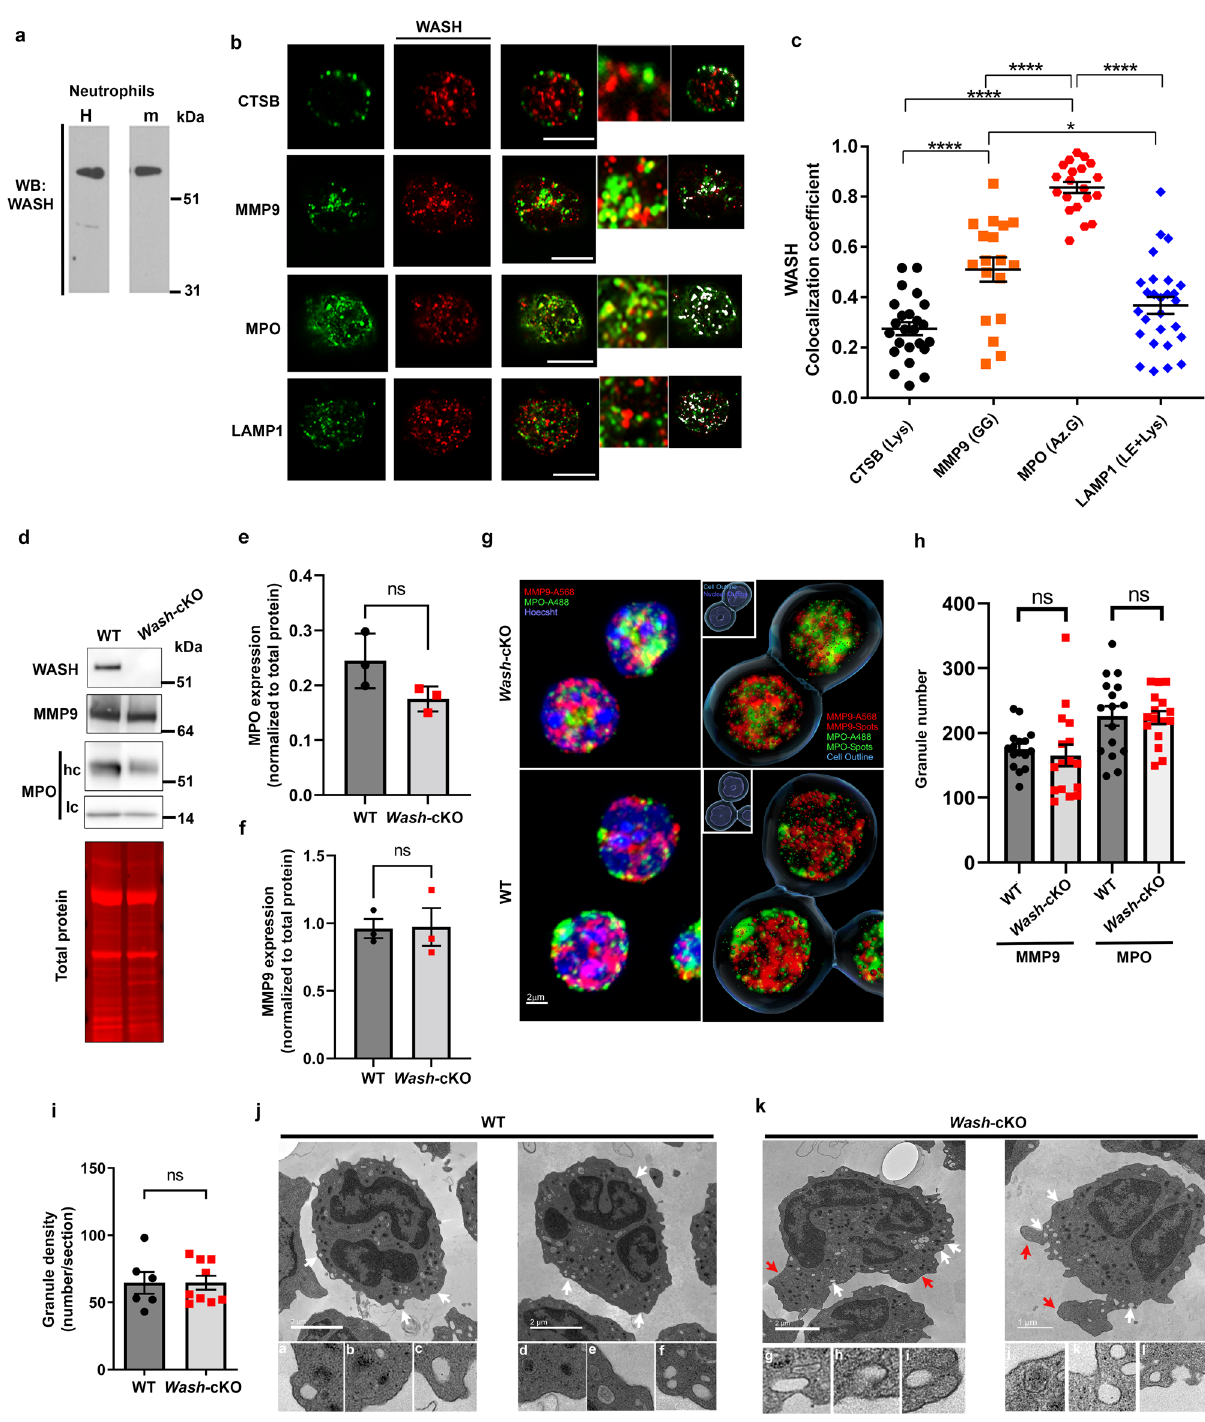
expansion (Fig. 1k, red arrows), the spontaneous fusion events observed in Wash -cKO neutrophils do not take place at sites of membrane extensions,instead, many ofthese events were observed at sites of membrane bending (white arrows in Fig.